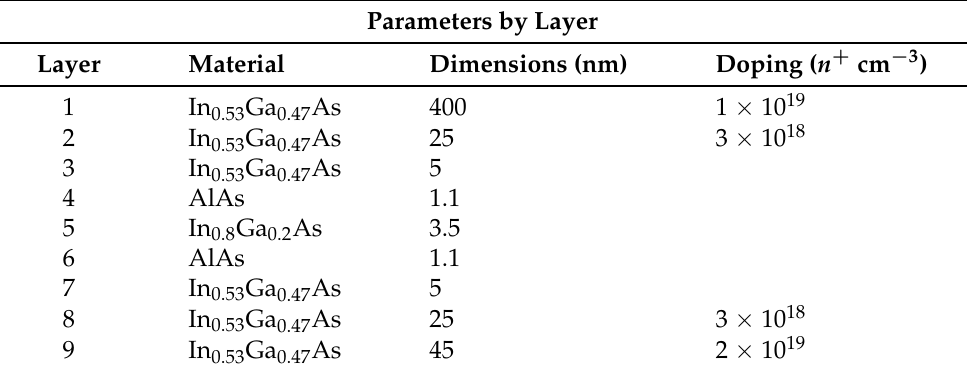
Table 3. Parameters corresponding to each of the layers in Figure 10.